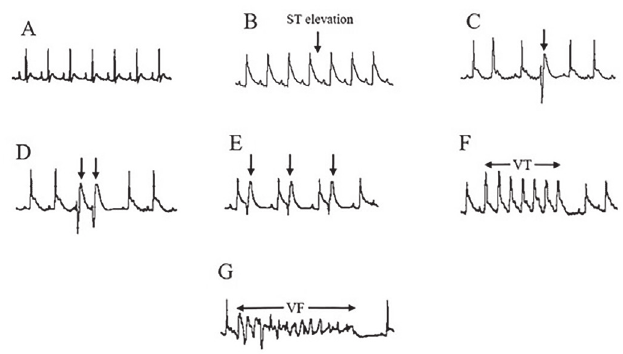
FIGURE 2 - Electrocardiogram recording; (A) During baseline; (B) during coronary artery occlusion; (C) ventricular ectopic beat (VEB); (D) couplet; (E) bigeminy; (F) ventricular tachycardia (VT); and (G) ventricular fibrillation